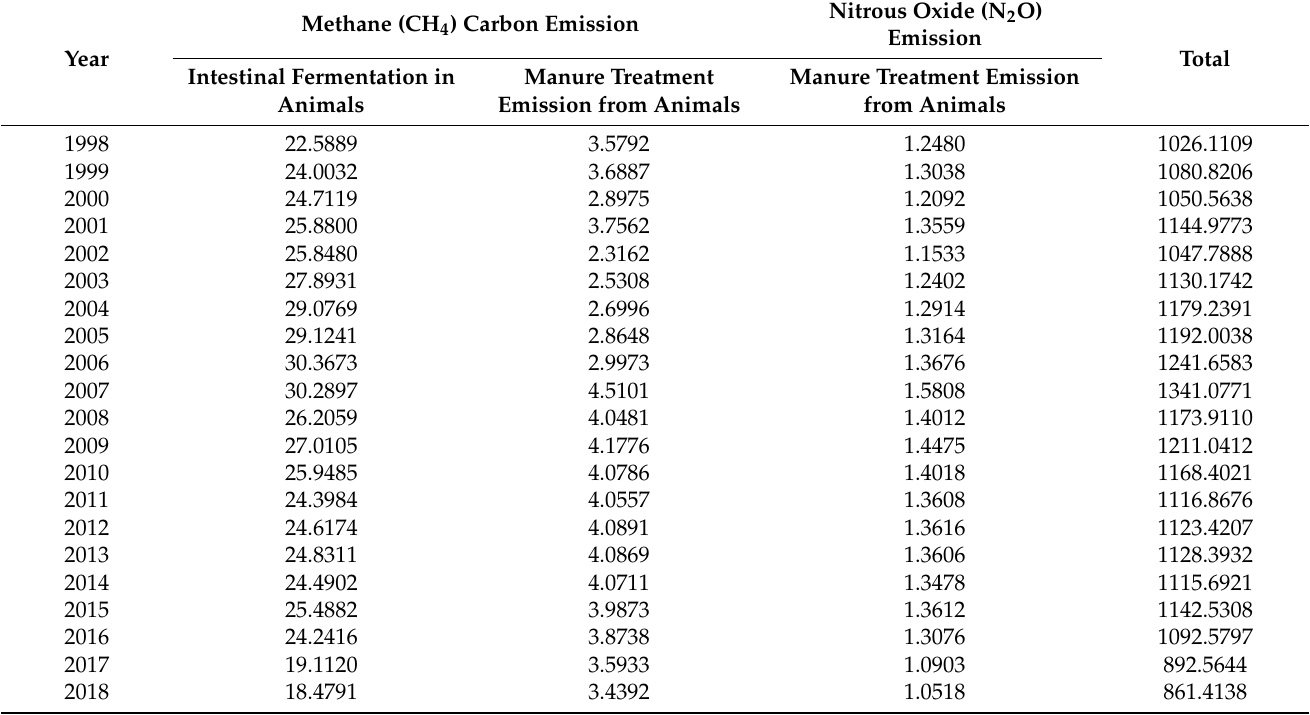
Table 4. Carbon emission from animal husbandry in Jilin Province from 1998 to 2018 (unit: 10,000 tons).